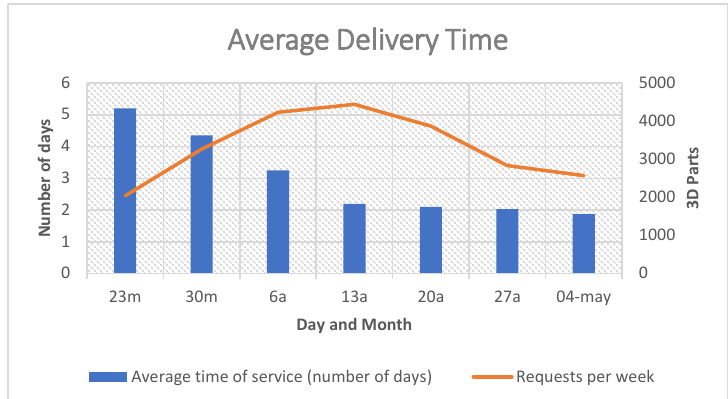
Figure 15. Average time of services (number of days). Average time, in days, needed to attend the applications. The data are recorded per week, from 16 March to 4 May